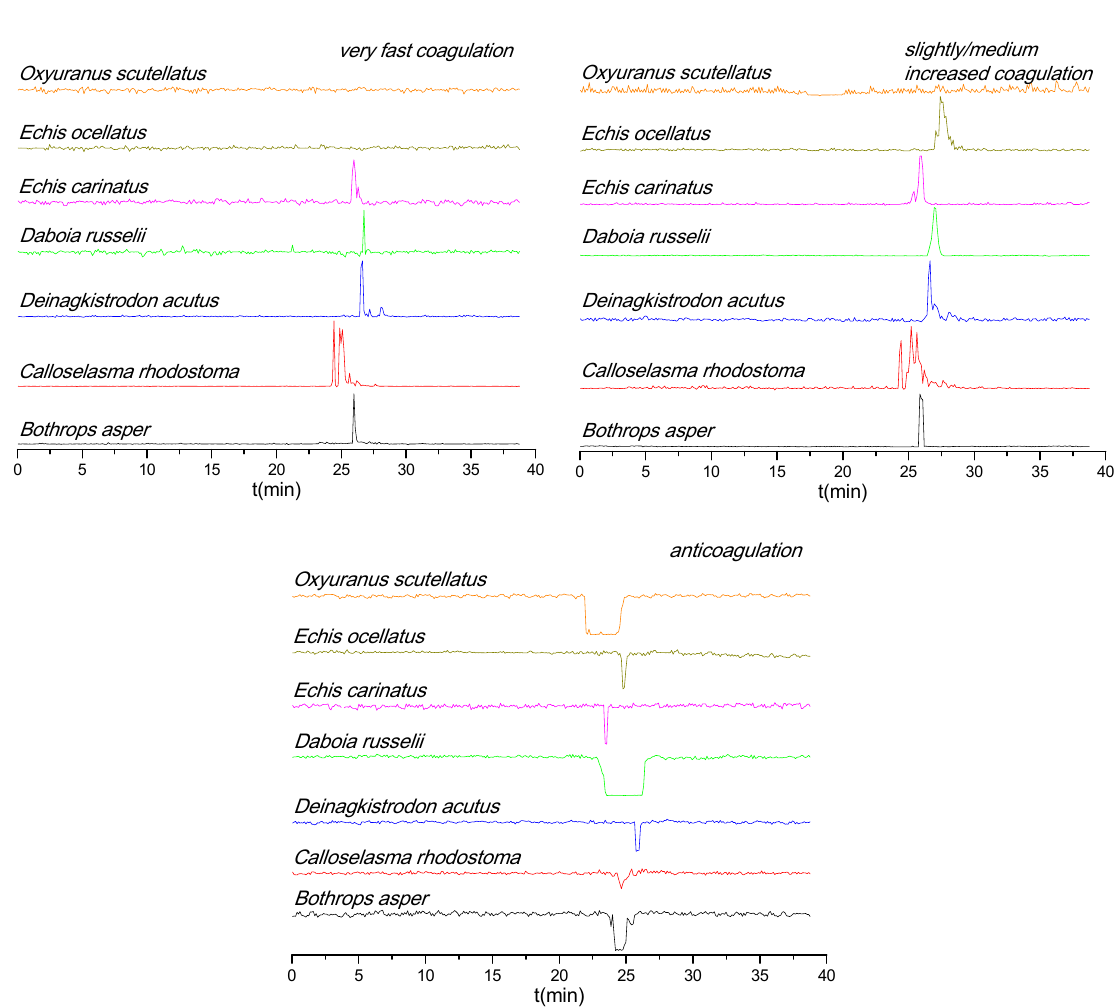
Figure 2. Coagulopathic bioactivity chromatograms of nanofractionated venom toxins. Anticoagulation is measured as negative signals and procoagulation as positive signals.